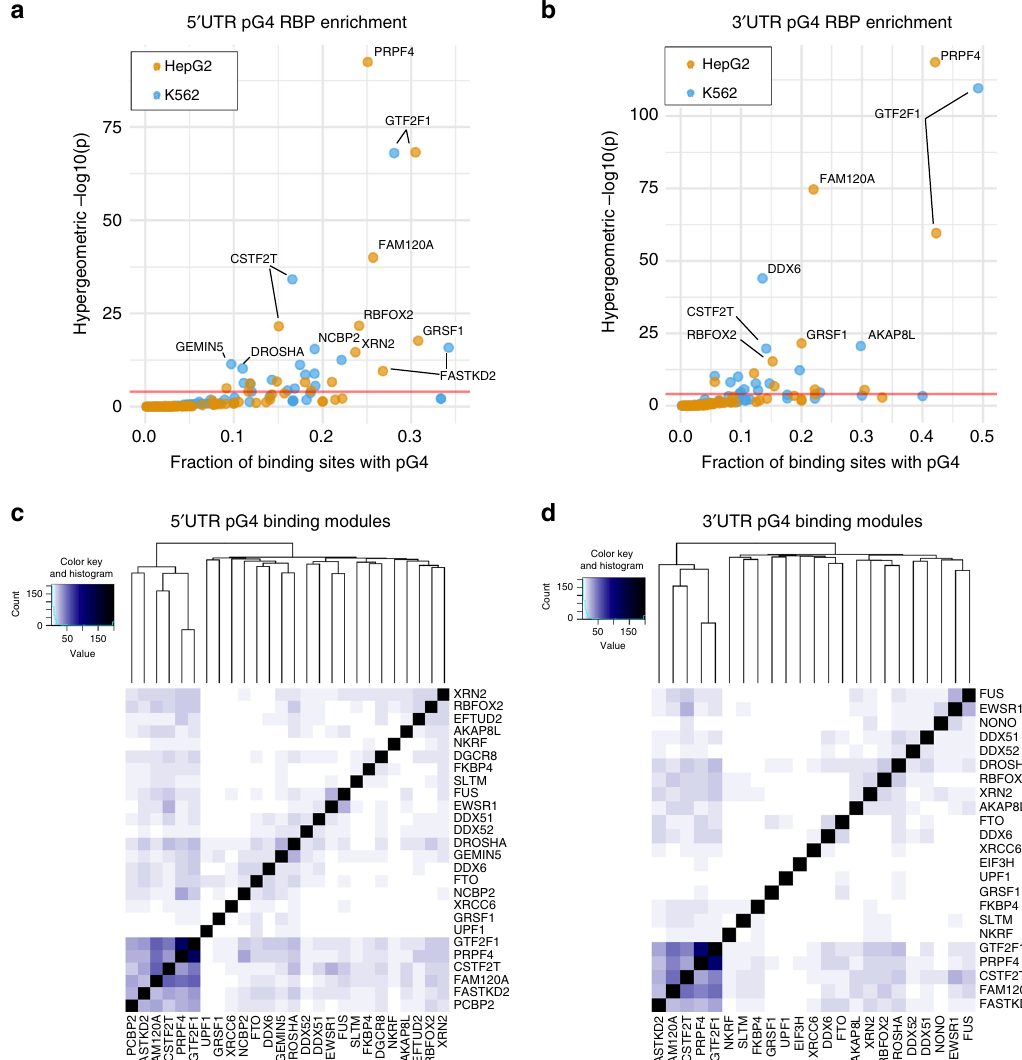
Fig. 4 Enrichment of speci fi c protein – pG4 binding sites using CLIP-seq data from ENCODE. a , b Enrichment of speci fi c proteins over pG4-binding sites within the 5 ′ UTR (left) and 3 ′ UTR (right) — red line corresponds to P = 0.0001 (hypergeometric test). c , d Heatmaps depicting the signi fi cance of overlap (hypergeometric − log P value) in pG4 gene targets for proteins found to bind pG4 sequences preferentially. Source data are provided as a Source Data fi